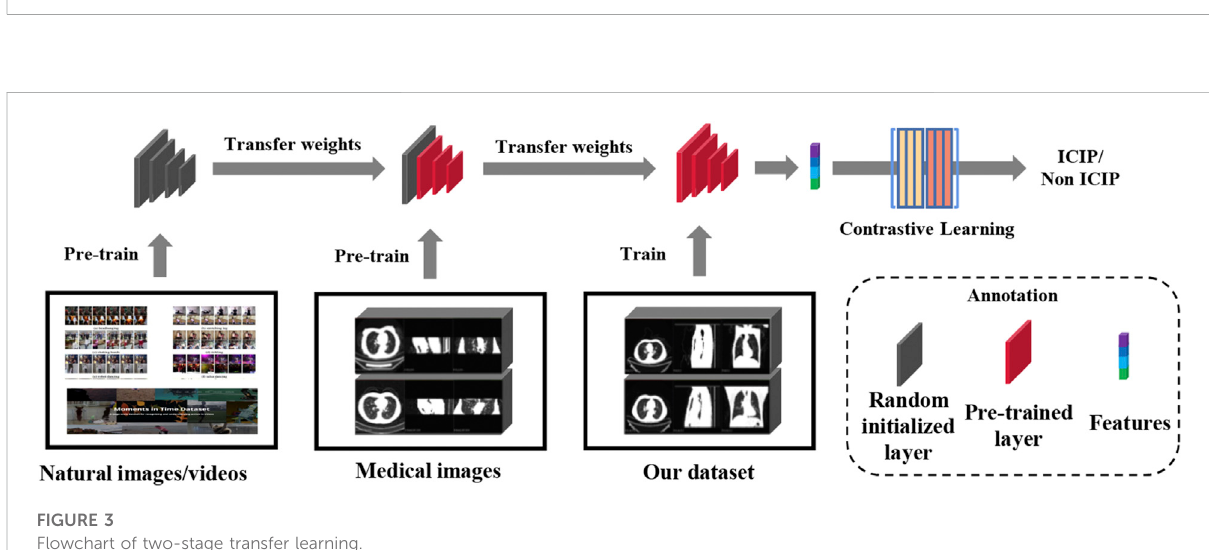
FIGURE 3 Flowchart of two-stage transfer